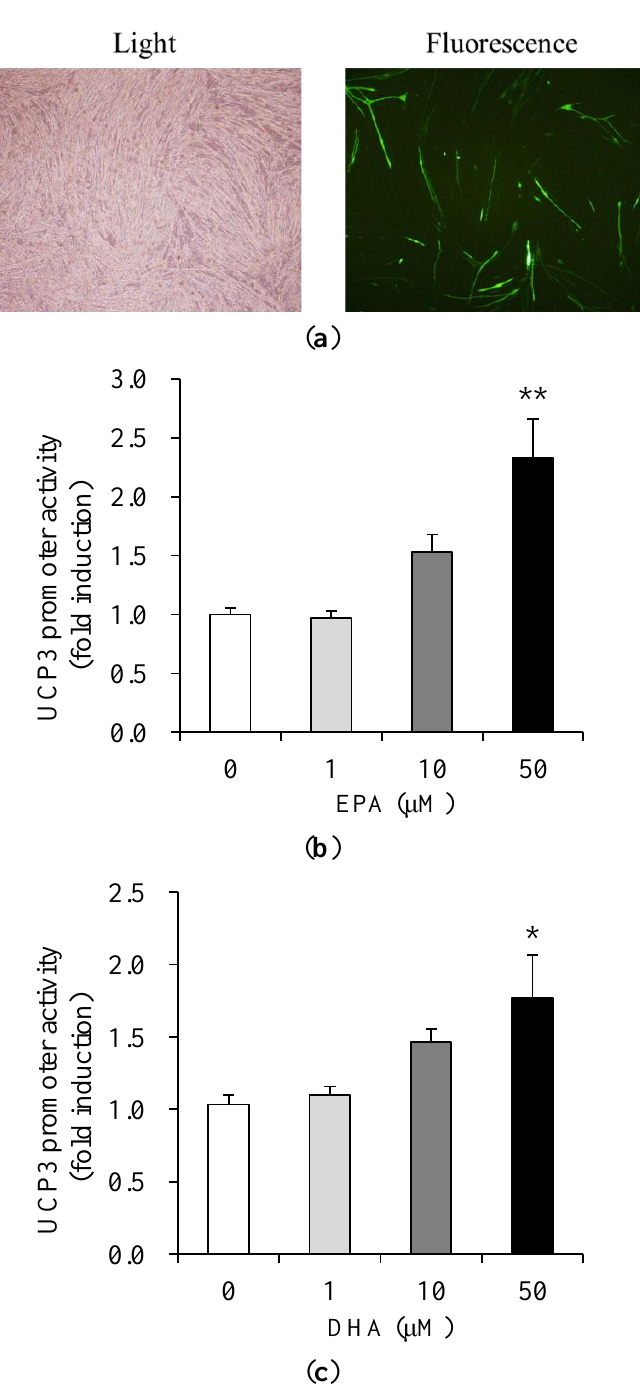
Figure 3. Effects of EPA and DHA on UCP3 promoter activity in muscle cells. Transfection efficiency ( a ) of differentiated C C muscle cells was analyzed with a GFP 2 12 expression vector. The GFP expression was observed under fluorescent microscope at 40× magnification. Cells were transfected with the UCP3 (−1790/+52 bp)/luc reporter gene and pCMV-β galactosidase, and were then incubated 1% BSA serum-free medium with the concentrations of EPA ( b ) and DHA ( c ) indicated, from 0 (control) to 50 μM, for 40 h. Promoter activities measured by luciferase activity were calculated in relative light units (RLU) and normalized to β-galactosidase activity. Values are expressed as mean ± SE ( n = 3) of three independent experiments. * P < 0.05 and ** P < 0.01 versus control